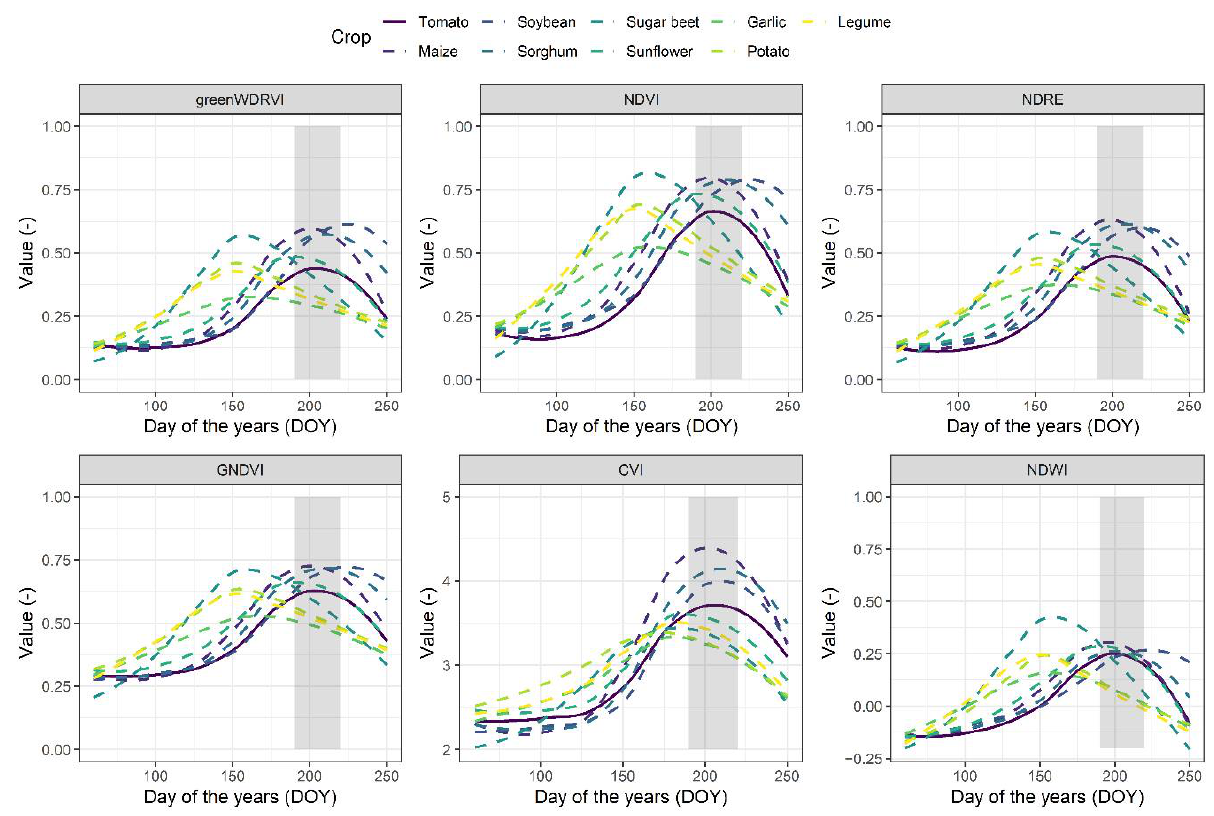
Figure 2. Temporal profiles based on the NDVI, NDRE, NDWI, GNDVI, CVI and greenWDRVI of the targeted crops during the growing season in the study area. The lines represent the average values of VIs, and the grey shadow represents the period between DOY 190 and 220. Table 2. Experimental ranges and levels of independent variables for central composite rotational design (CCRD) used in the optimization of tomato crop mapping. The lead time is expressed in day of the year